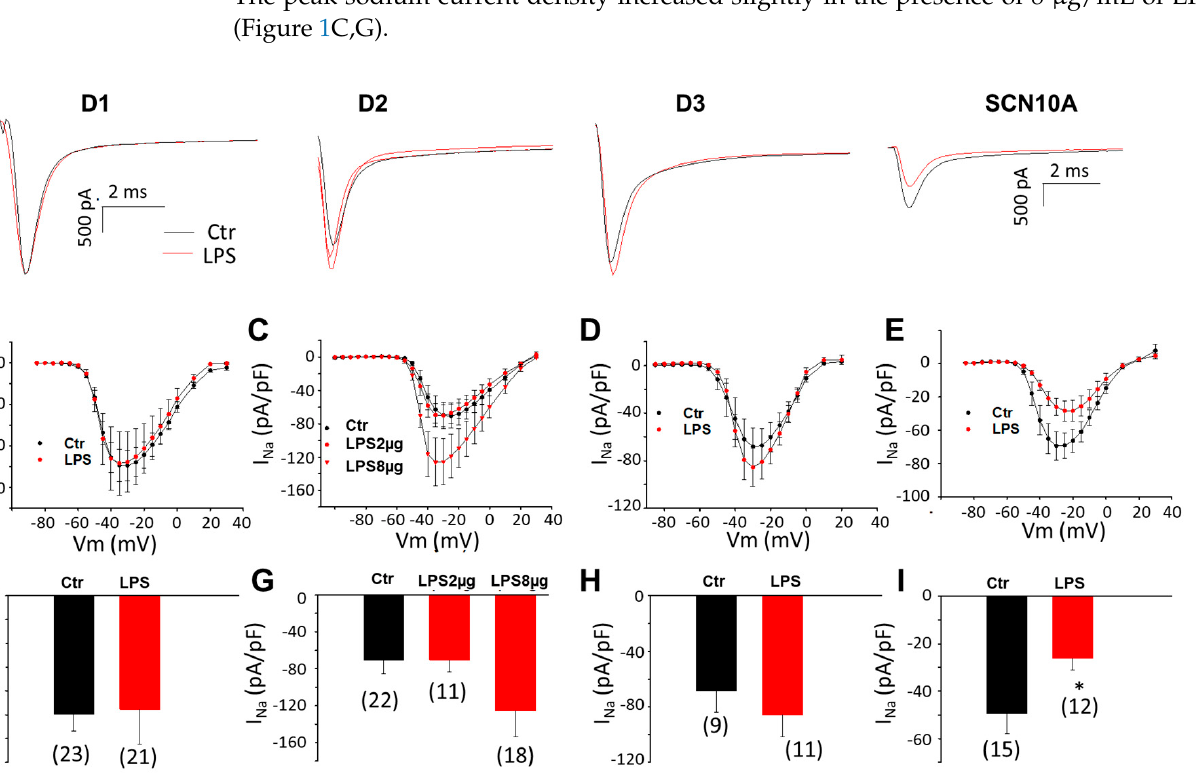
Figure 1. LPS suppressed peak sodium channel currents in hiPSC-CMs from BrS-patients. Cells were treated with vehicle (same amount of water, Ctr) or LPS of 2 μ g/mL or 8 μ g/mL (in D2 cells) for 48 h and then peak sodium channel currents (I Na ) were recorded. ( A ) Representative traces of peak I Na at − 30 mV were recorded in hiPSC-CMs from healthy donors (D1, D2, and D3) and the BrS-patient (SCN10A) in absence (Ctr) and presence of LPS (2 µ g/mL). ( B ) Current-Voltage (I–V)